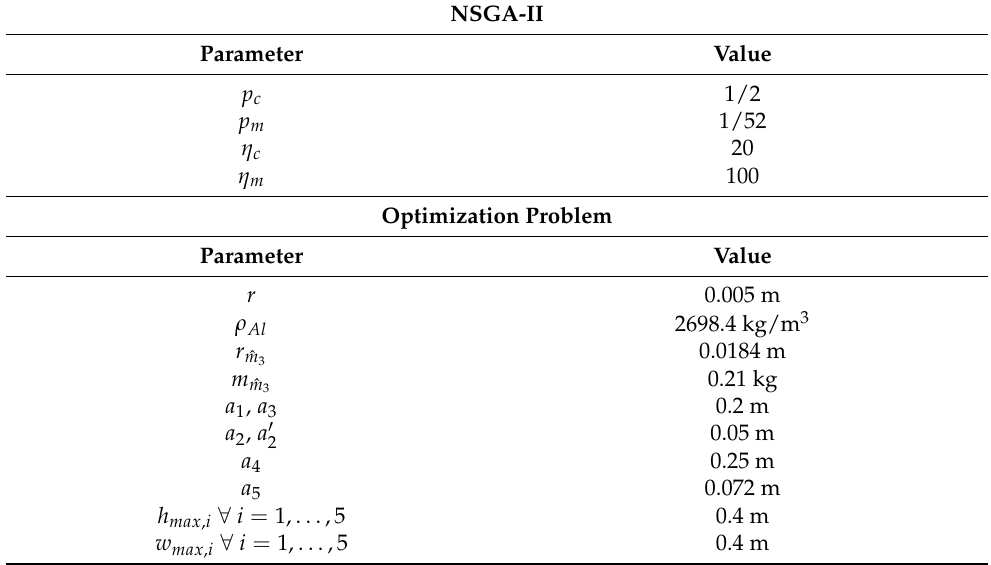
Table 1. Parameters of the NSGA-II and the optimization problem.